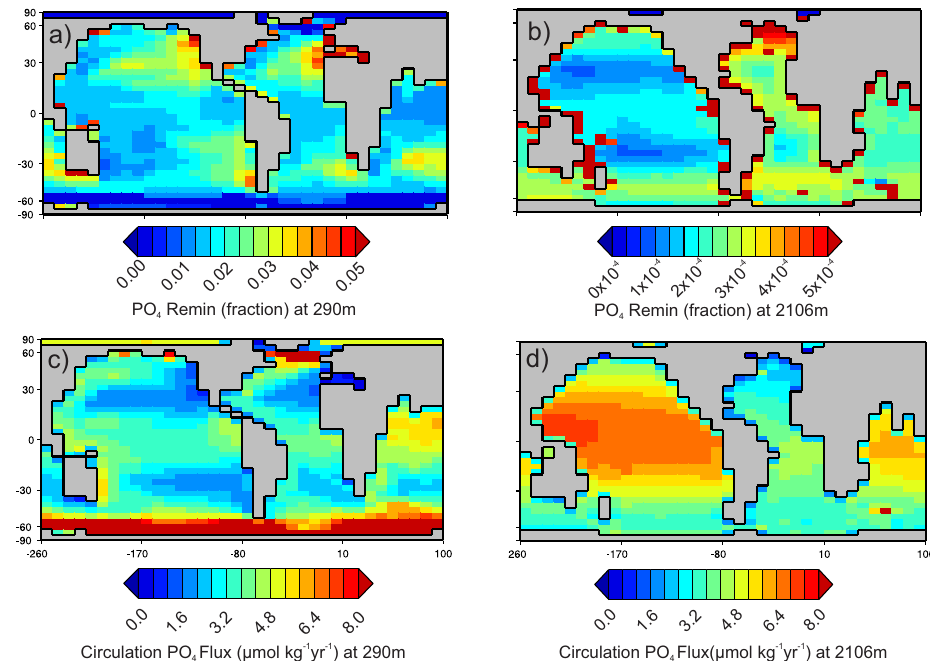
Figure 7. Comparison of inputs of PO 4 from remineralisation and circulation at steady state. (a) PO 4 remineralisation as a proportion of the total PO 4 flux into each grid box calculated using the synthetic tracer field at 290m and (b) 2106m. (c) The flux of PO 4 into each grid box from circulation only (µmolkg − 1 yr − 1 ) from the synthetic tracer fields at 290 and (d) 2106m.